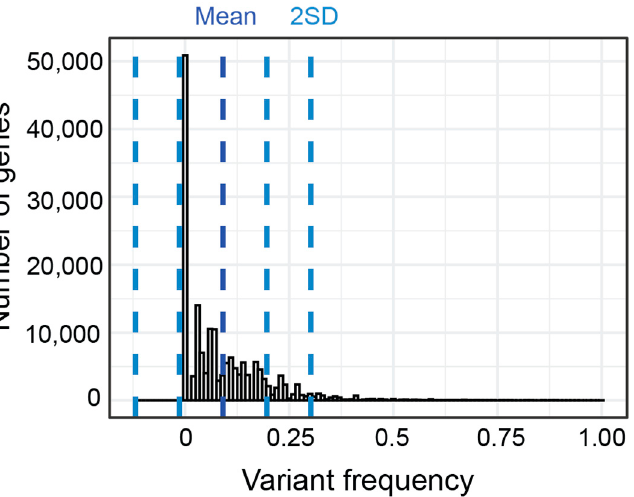
Figure 7. Distribution and standard deviation (blue lines) of GVF for all genes for all subgroups.